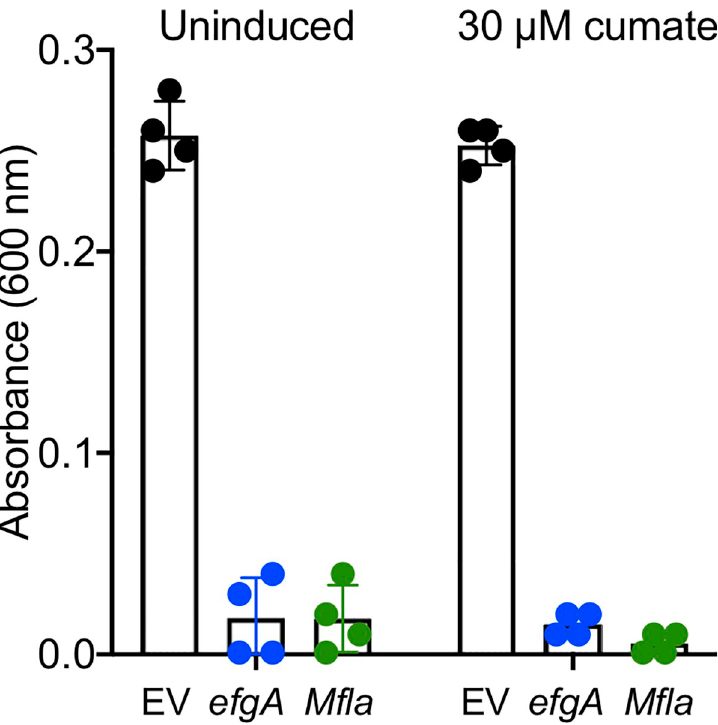
Fig 8. EfgA from Methylobacillus flagellatus complements the M . extorquens Δ efgA mutant. Derivatives of the Δ efgA mutant containing pLC290 were grown in liquid MP medium with 8 mM formaldehyde as a sole source of carbon and energy. Strains contained expression plasmids that were either an empty vector control (CM4625, EV, black), expressed EfgA from M . extorquens (CM4126, efgA , blue), or the homolog from M . flagellatus (CM4182, Mfla_1444 , green). Expression from pLC290 is cumate-inducible [133]; uninduced were grown without the addition of cumate. Error bars represent the standard error of the mean for four biological replicates. The original data shown in this and all other figures are available in Supporting information file S1